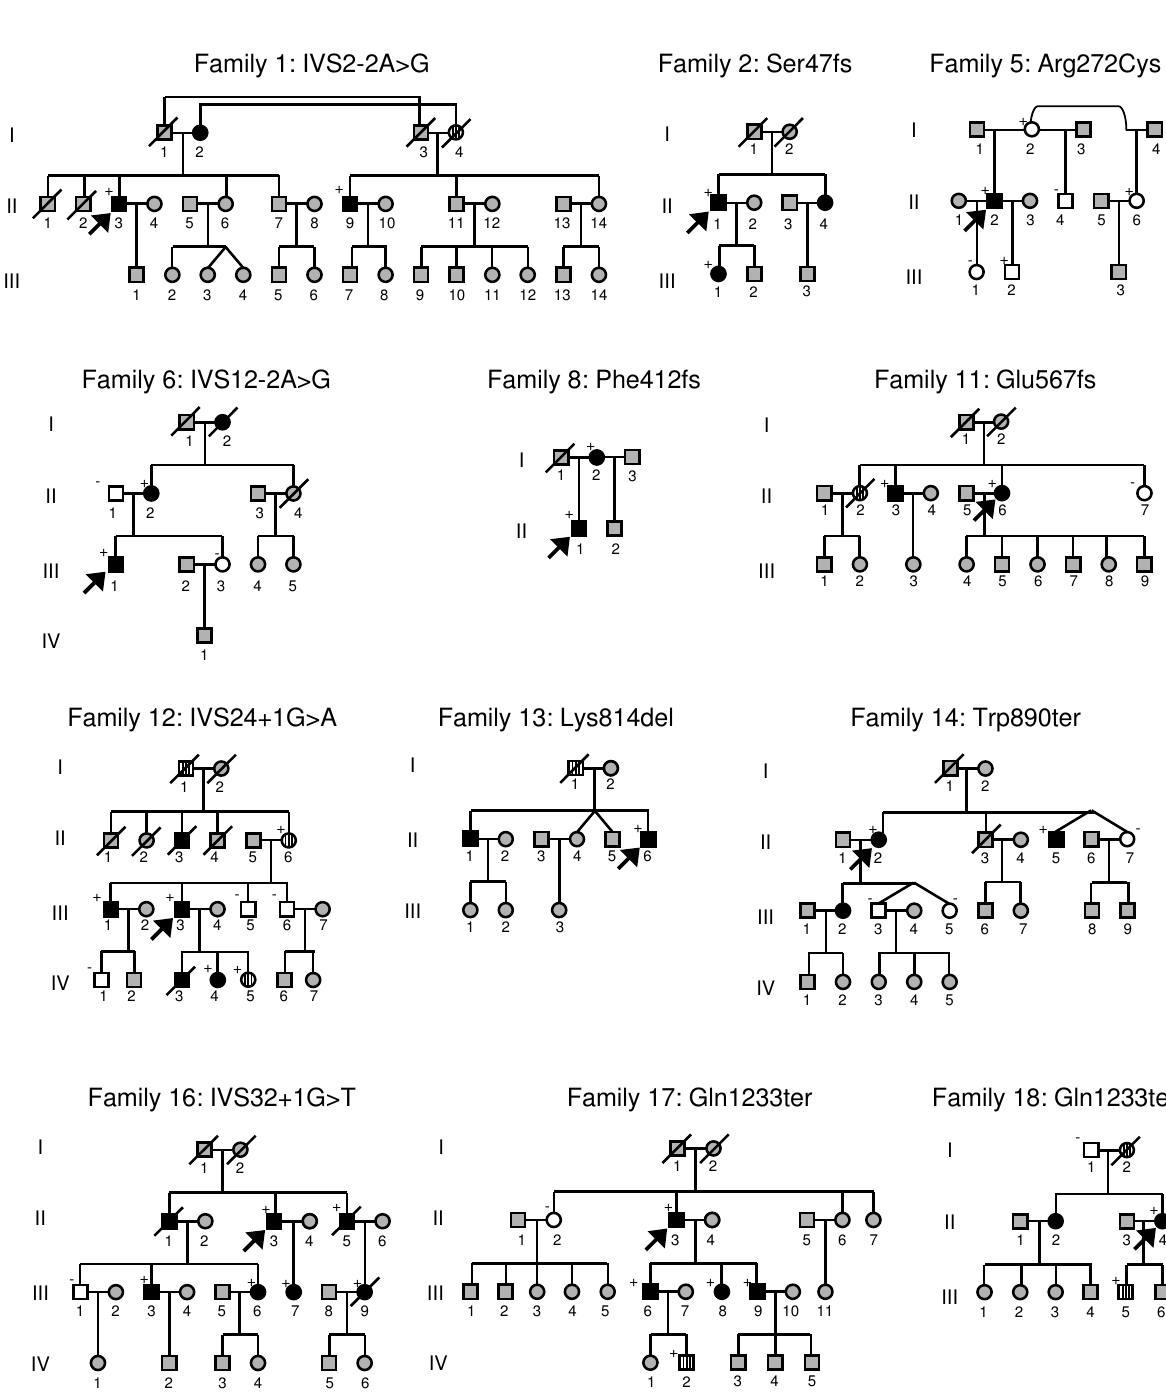
Figure 1 Pedigrees of affected families: Open and black symbols represent unaffected and affected individuals, respec- tively. Dashed symbols indicate individuals with presumed or borderline disease phenotype. Grey symbols denote individuals with unknown clinical status. (+) and (-) symbols indicate presence and absence of the mutation, respectively. Index patients are marked by an arrow. Slanted bars denote deceased